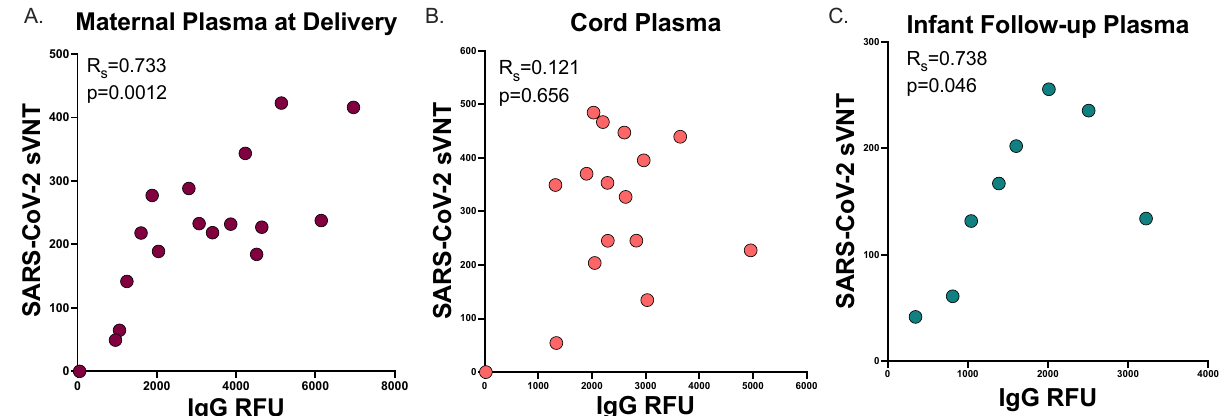
fl uorescence units (RFU) correlation (Spearman ’ s rank correlation). Two-sided p values were calculated for all test statistics. Source data are provided as a source data fi